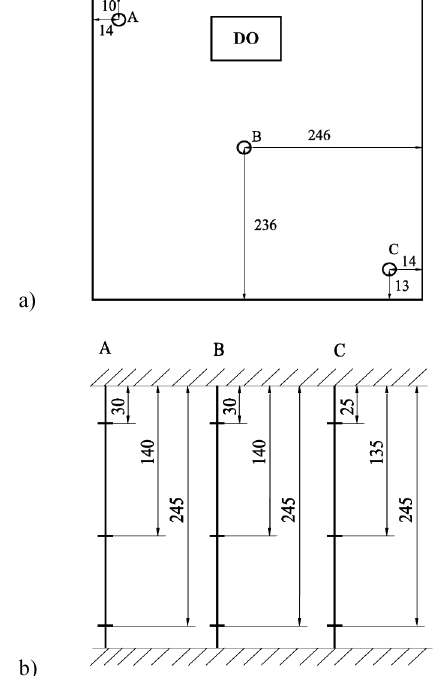
Fig. 4. Scheme of vertical (a) and horizontal (b) positioning for the sensors measuring CO concentration, installed on A, B and C columns (numbers – in cm; DO – burning